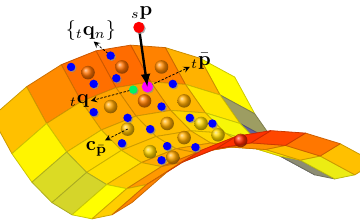
Figure 4. A simple example of B-spline intensity surface model. The grid surface depicts the modeled continuous intensity surface with colors representing intensities and spheres in the center of surface grids representing control points of the B-spline surface model. s p denotes the selected point and q n denotes query points. s p is transformed to the reference frame of { t } denotes the nearest neighboring query point of t ¯ p